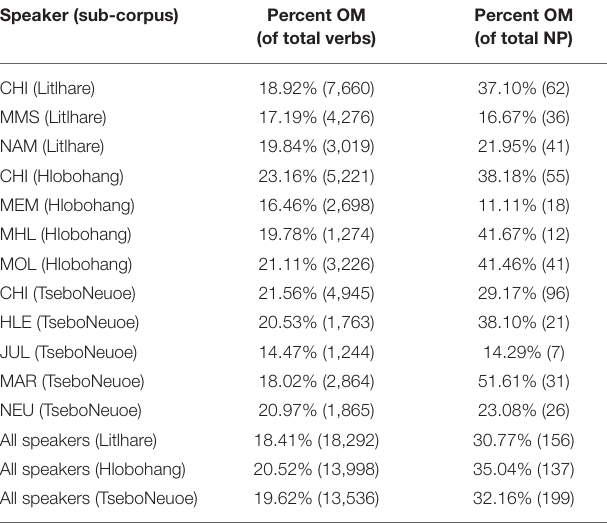
TABLE 2 | Proportions of all verb tokens and of narrative past tokens with object